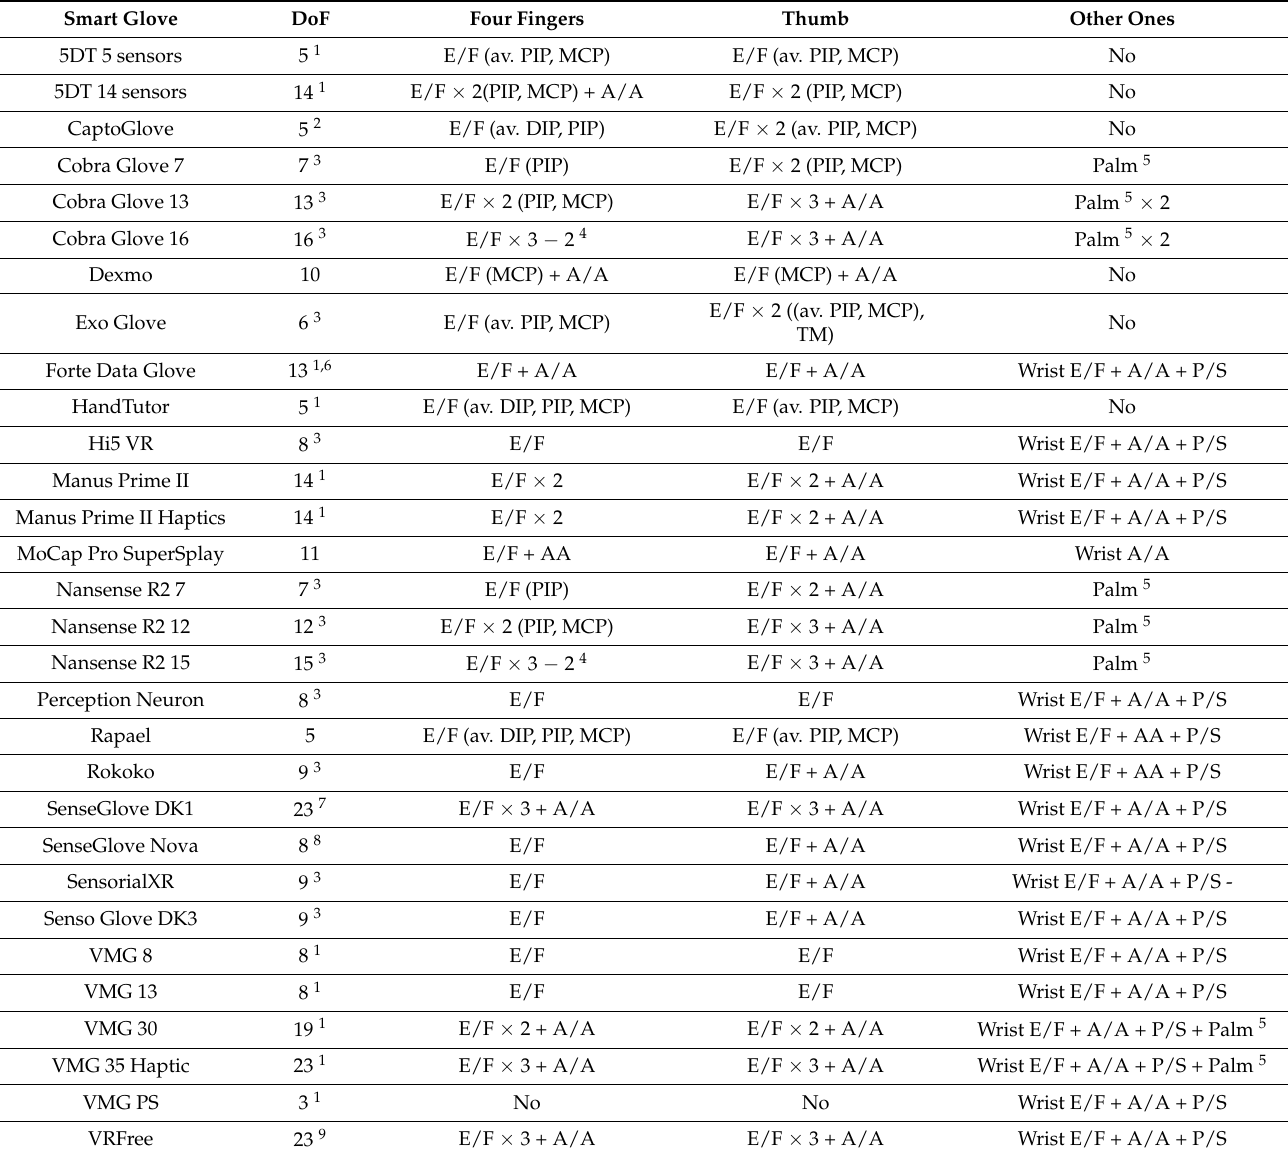
Table 5. DoF for commercial smart gloves (av. is used to indicate that the average movement of two joints is measured). Smart